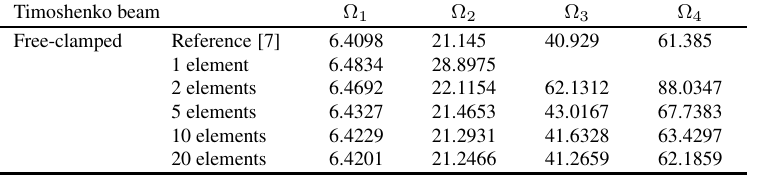
Table 4 First four dimensionless natural fequencies of a cantilever Timoshenko beam